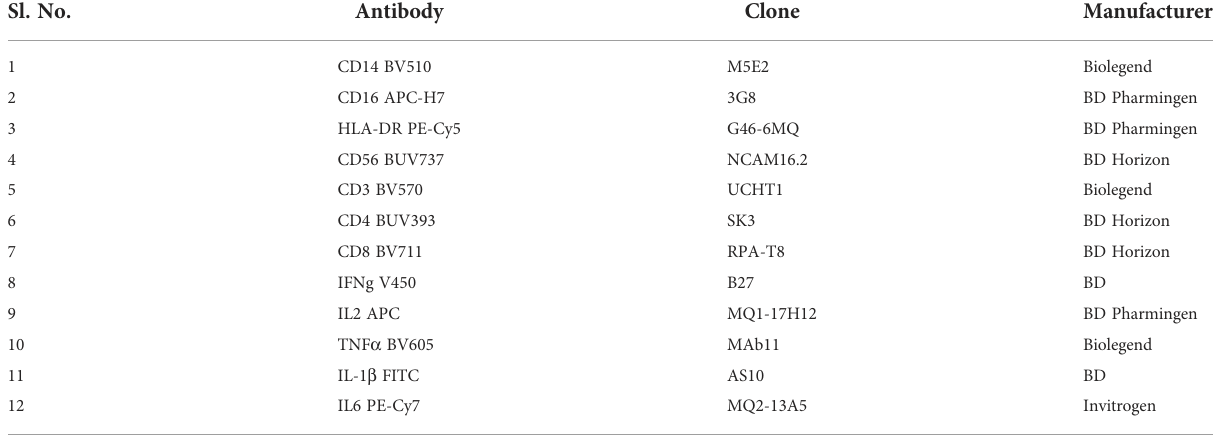
TABLE 2 Antibody panel for innate immunity and to track BCG-speci fi c T cell responses. Sl.